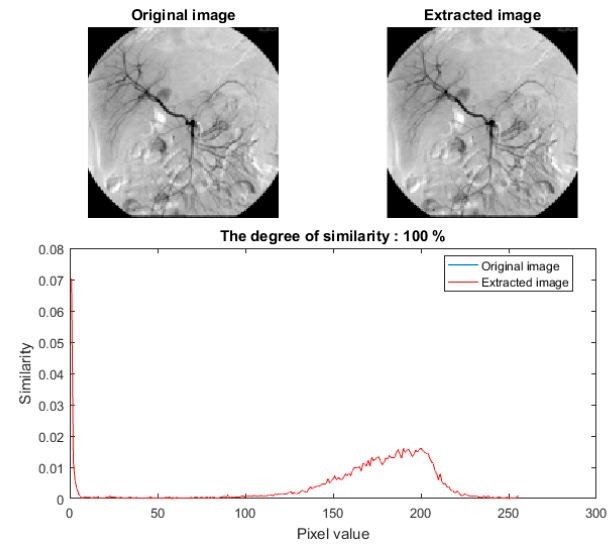
Figure 5. Visual quality for marked (i.e. stego) versions of greyscale images in Figure 3.